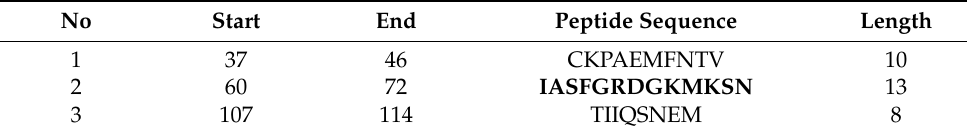
Table 1. Synthesized peptides of CD8 α molecules in olive flounder.